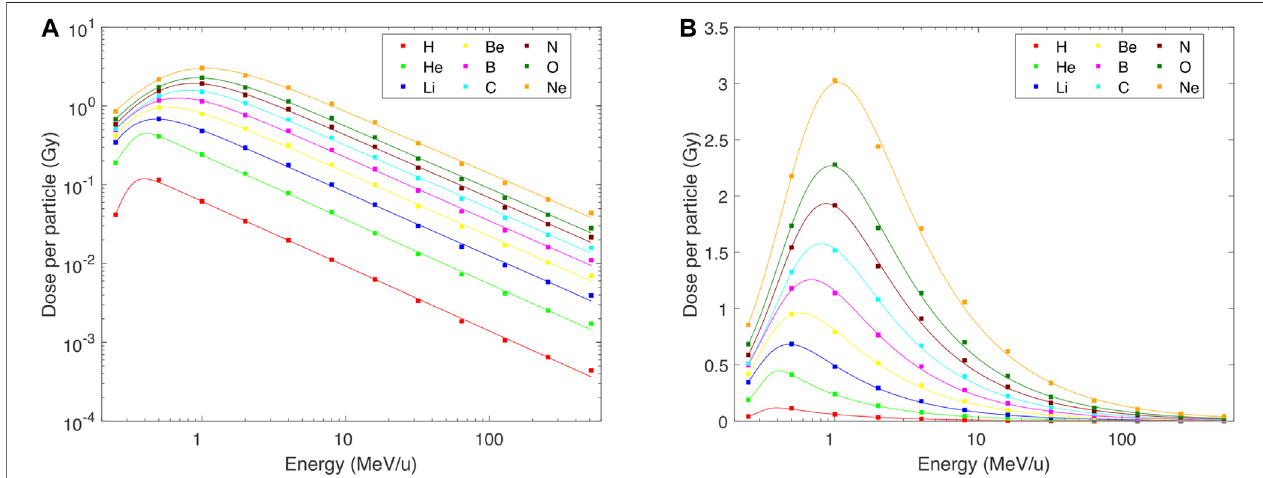
FIGURE 1 | Mean dose deposited to the lymphocyte nucleus per single track of H – Ne ions with starting energies from 0.25 to 512 MeV/u, as simulated with PARTRAC event-by-event track-structure simulations (symbols) and fi tted by analytical formulas Eq. 1 (lines) with parameters listed in Table 1 . Panel (A) in logarithmic scale to highlight the wide range of values and the quality of fi ts; panel (B) in linear scale.